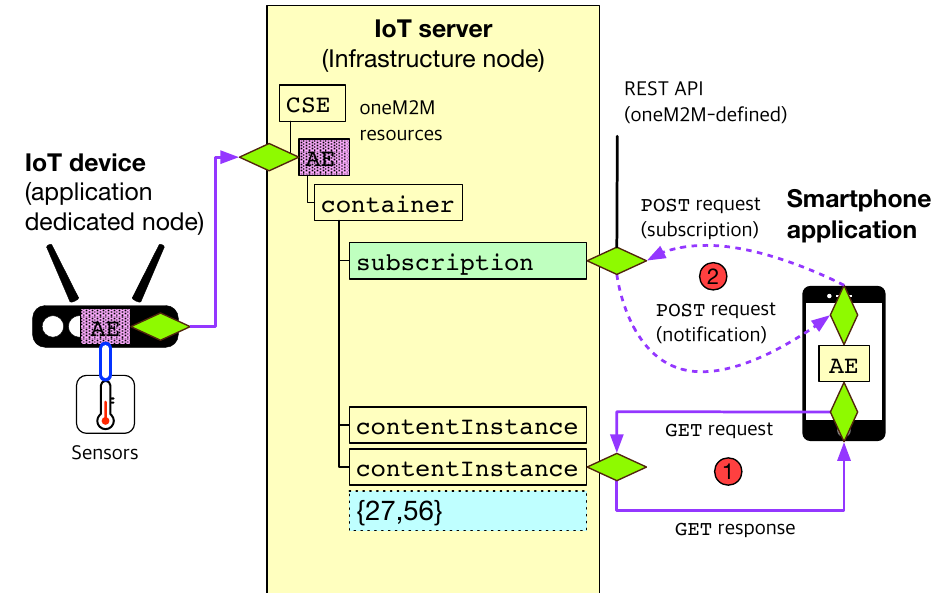
Figure 2. The proposed sensing scenario using oneM2M standard-based sensing capabilities.